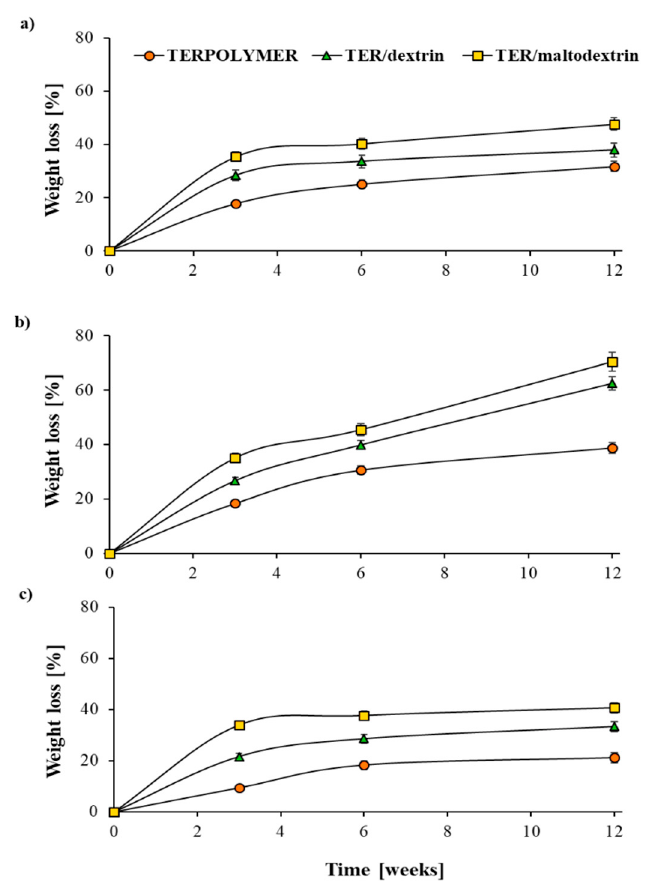
Figure 3. Percentage weight loss of microspheres of TERPOLYMER; TER / dextrin and TER / maltodextrin, ( a )—in water, ( b )—in activated sludge, ( c )—in soil. The error bars are smaller than the symbols where they are not shown.